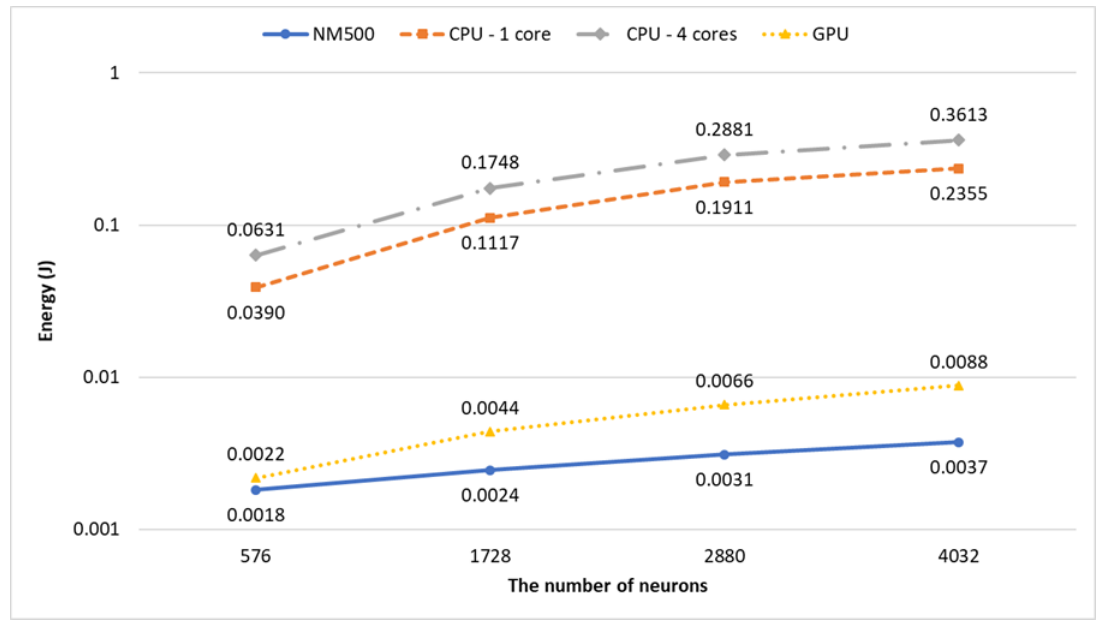
Figure 6. Energy per test data.